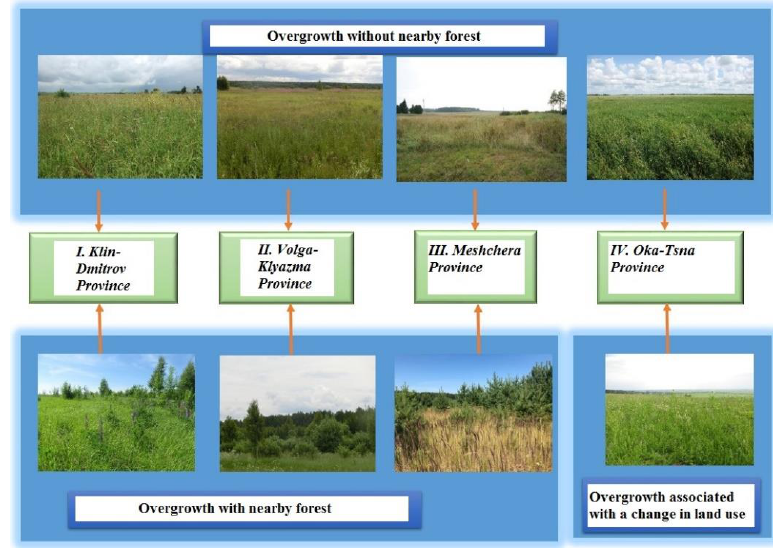
Figure 4. Examples of overgrowth in post-agrogenic